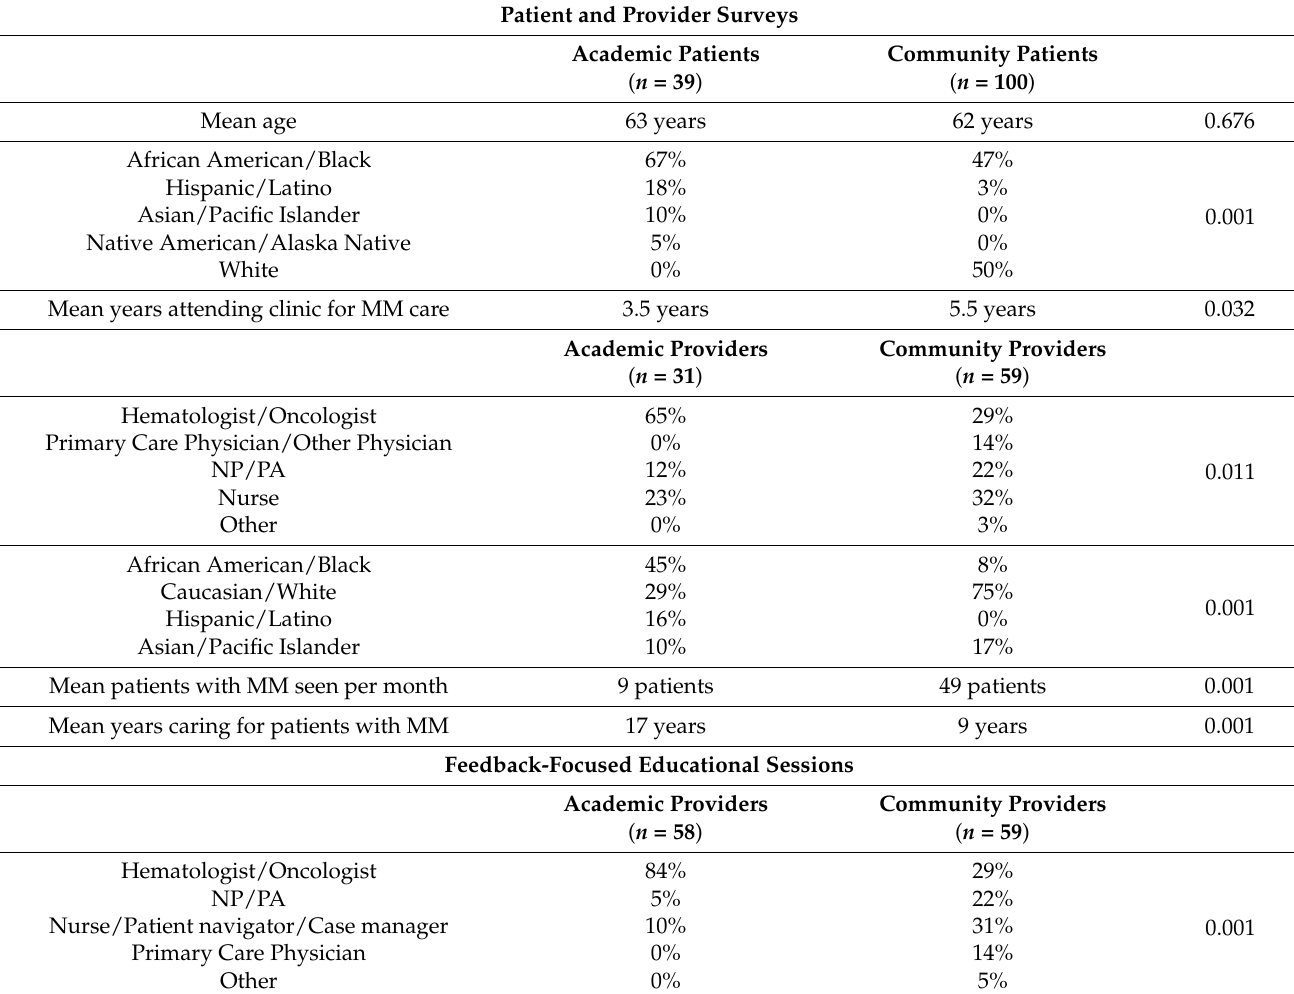
Patient and Provider